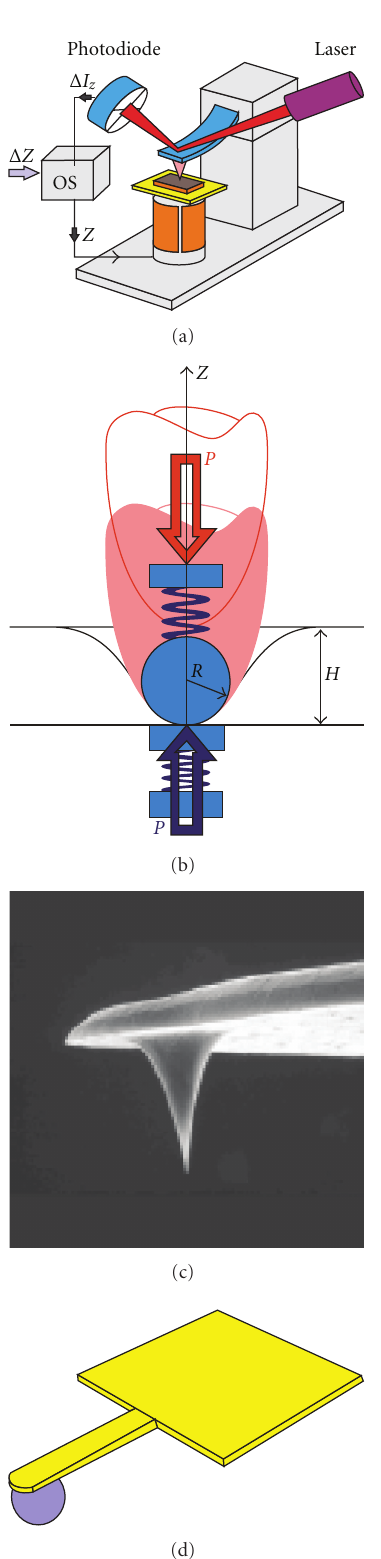
Figure 2: Scheme of the indentation with AFM: (a) schematic diagram of AFM with laser-beam system of the cantilever deflection detection; (b) geometry set of the elastic modulus calculation; (c) AFM probe tip used as indenter for nanometer-level measurement; (d) ball indenter for macrolevel